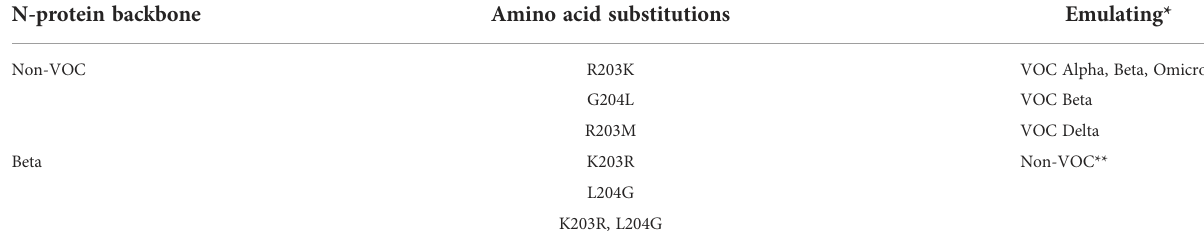
TABLE 6 Overview of the induced amino acid exchanges (PCR-based mutagenesis) in SARS-CoV-2 recombinant N-protein. N-protein backbone